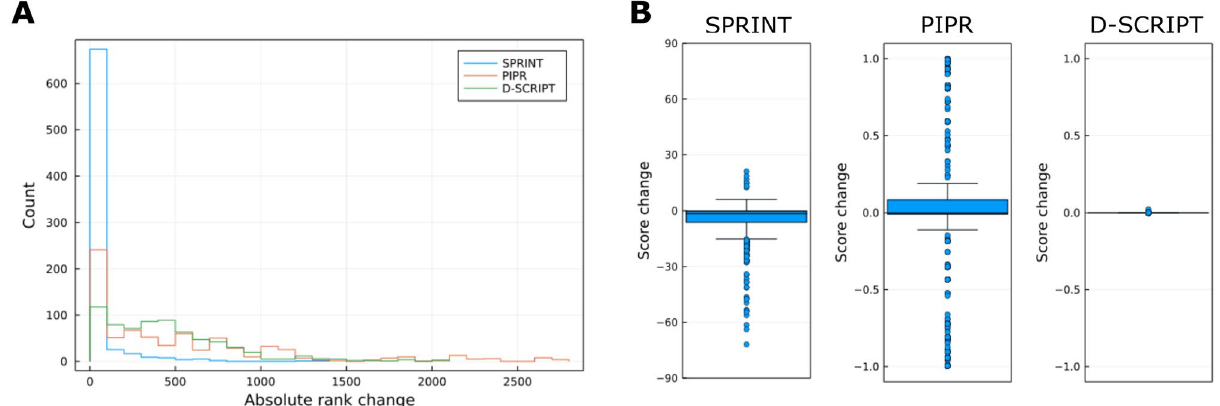
Figure 4. Distribution of changes in rank and score. The one-to-all curves were regenerated for each peptide by mutating each non-Gly residue to Gly to evaluate ( A ) the absolute change in rank on the one-to-all curve and ( B ) the change in score. As a reminder, SPRINT scores are unbounded, while PIPR and D-SCRIPT scores are probabilities that range from 0 to